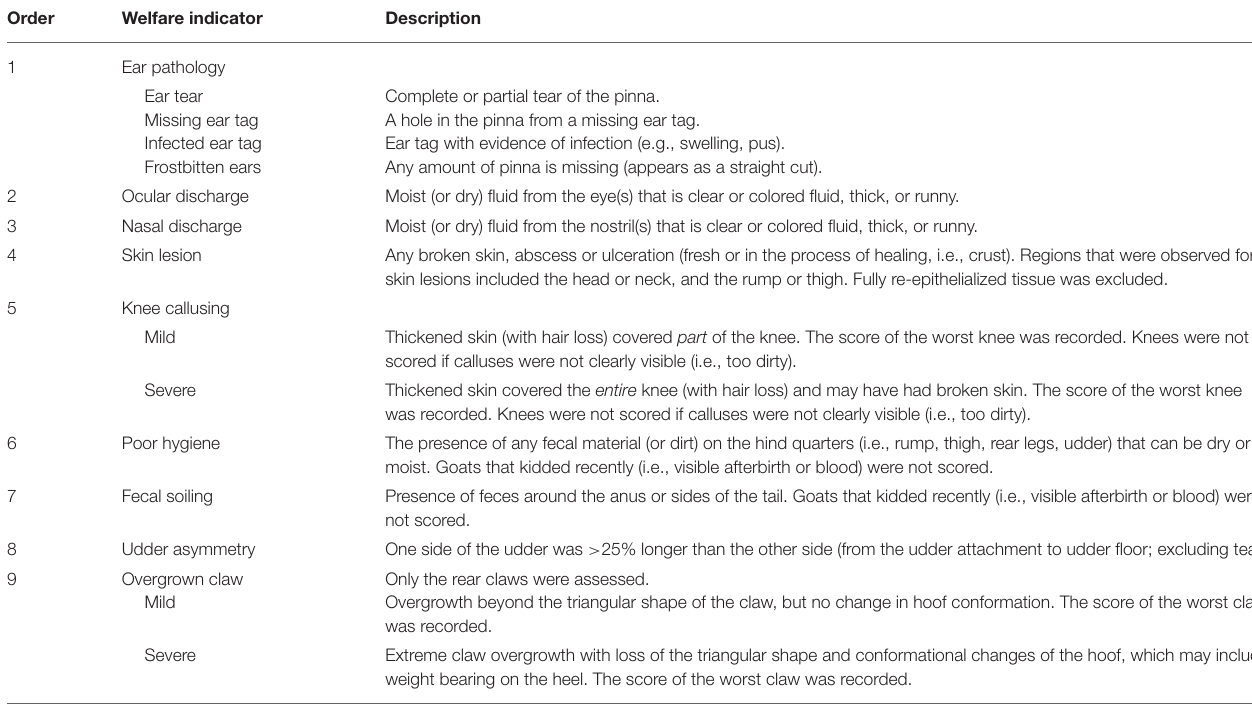
TABLE 1 | Descriptions of the individual-level welfare indicators and the order of which they were assessed for the dairy goat welfare assessment protocol. Order Welfare indicator